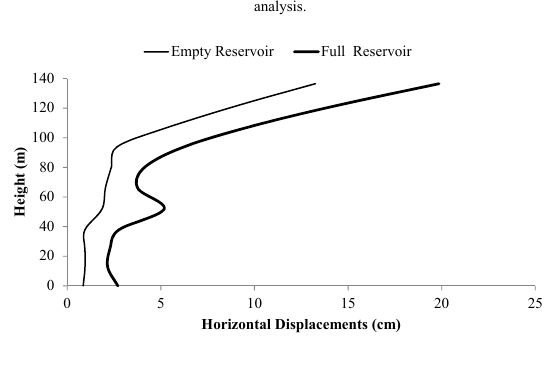
d) The maximum horizontal displacements in upstream direction according to non-linear analysis. Fig. 14. The maximum horizontal displacements in I-I section. Fig. 14. The maximum horizontal displacements in I-I